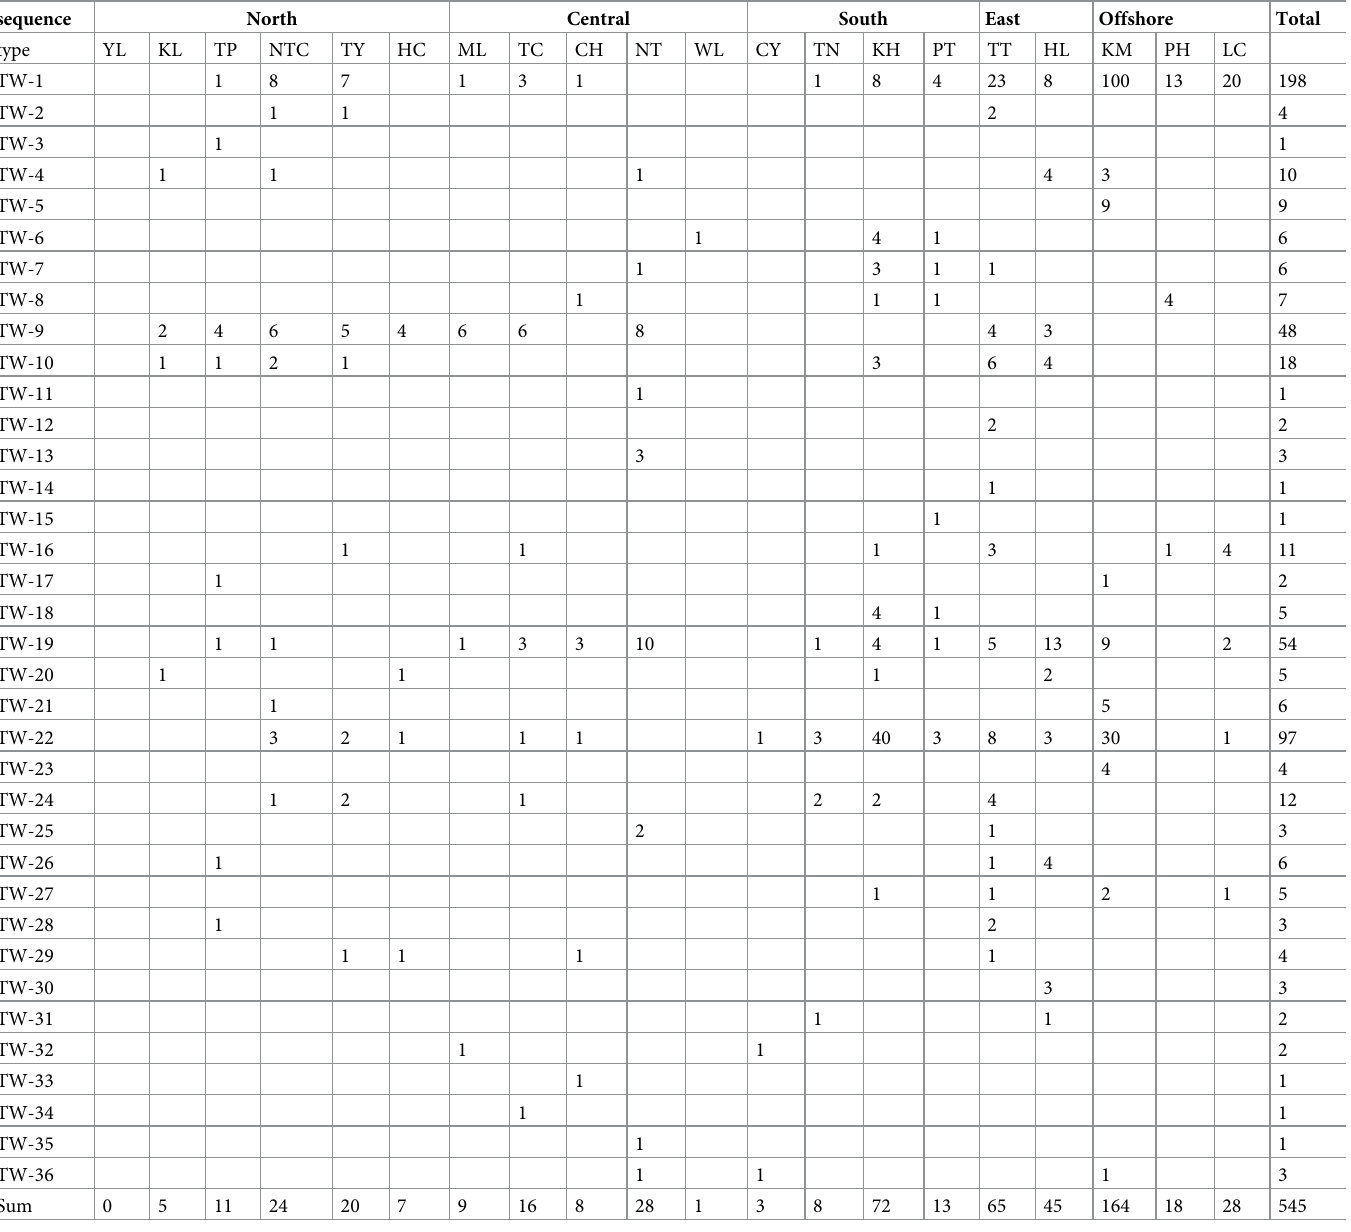
Table 2. Geographic distribution of sequence